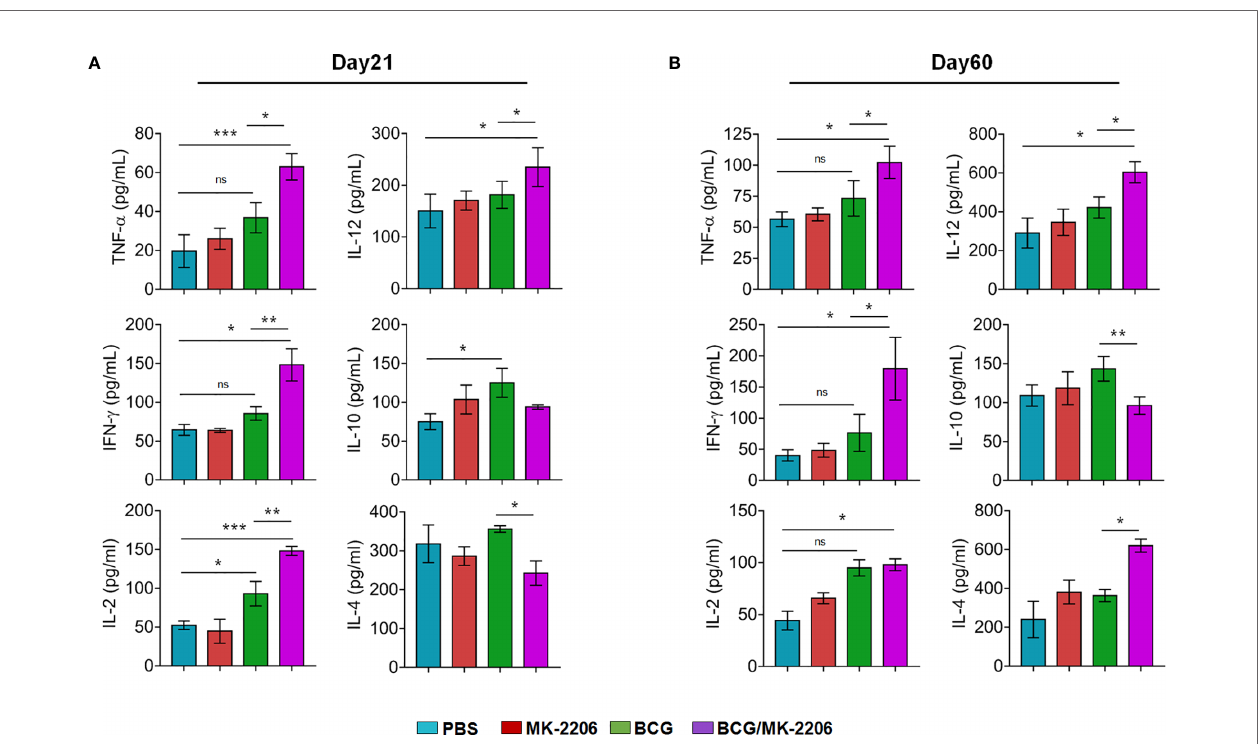
FIGURE 5 | BCG/MK-2206 prime boost regimen enhances Th1 responses in mice. Splenocytes were isolated at 21 days (A) and 60 days (B) post-immunization and were stimulated ex-vivo with PPD for 48 h as described in Materials and Methods . The concentrations of representative Th1 cytokines (TNF- a , IFN- g , IL-2, IL-12) and Th2 cytokines (IL-10, IL-4) were measured in the culture supernatants by ELISA. The data shown is mean ± SEM obtained from a single experiment (n = 5 animals/group). ns, non-signi fi cant; Statistical differences were obtained for the indicated groups. *p < 0.05; **p < 0.01; ***p < 0.001. ns, non-signi fi